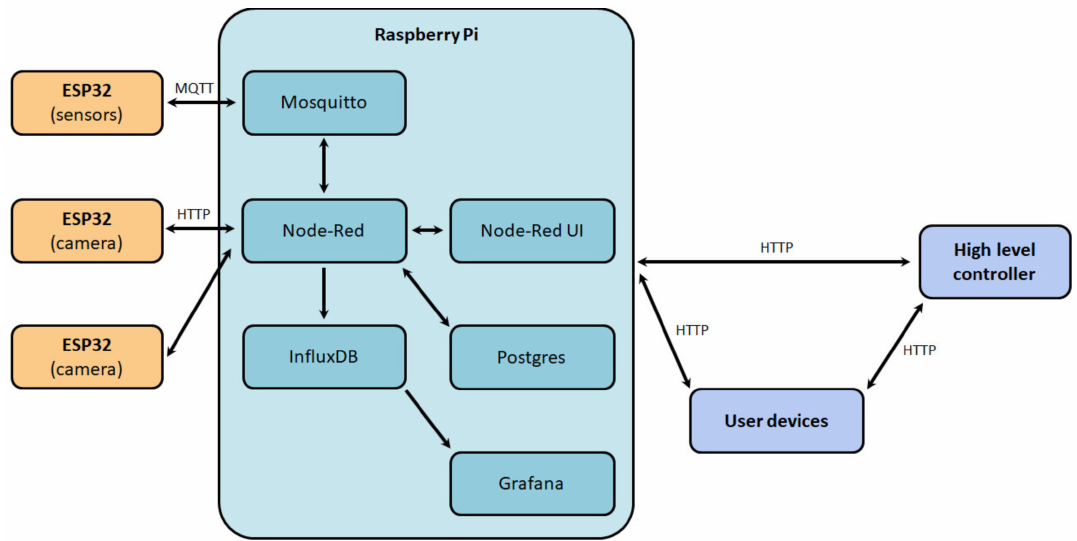
Figure 12. The software structure of the digital production